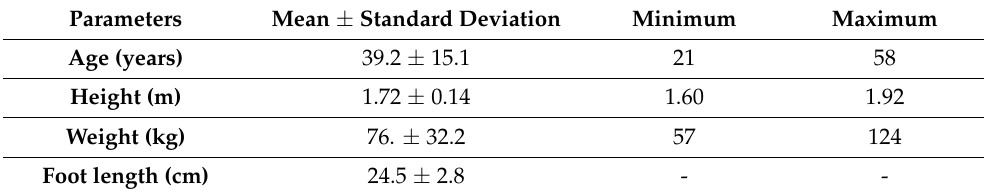
Table 1. The participants demographic and anthropometric characteristics 1 .